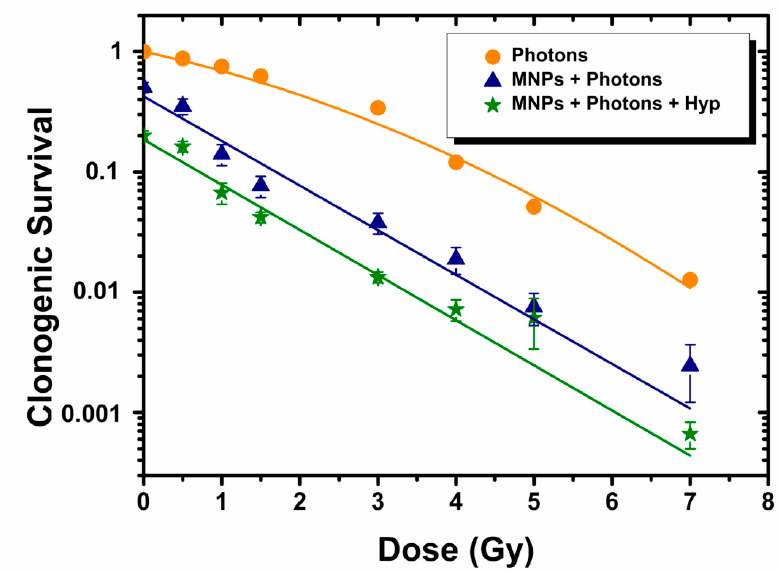
Figure 5. Clonogenic survival of BxPC3 cells incubated with or without MNPs, irradiated with photons (0–7 Gy) and combined (or not) with Hyp. Solid lines represent the best fit of the clonogenic survival (CS) curve as a function of the radiation dose D according to the law CS ∝ exp(– α D- β D 2 ) for photons alone, and to CS ∝ exp(– α D) for the other two treatments. From the fit: α Photons = 0.32 ± 0.06 Gy − 1 ; = 0.05 ± 0.01Gy − 2 ; α = 0.85 ± 0.09Gy − 1 and α = 0.86 ± 0.06 Gy − 1 . β Photons MNPs + Photons MNPs + Photons + Hyp In a similar way to the CNAO experiments, three treatment modes were used: (i) photon irradiation alone (orange circles), (ii) photon irradiation after the administration of MNPs for 48 h ◦ (navy triangles) and (iii) photon irradiation on cells incubating MNPs combined to 30 min at 42 C Hyp treatment (green